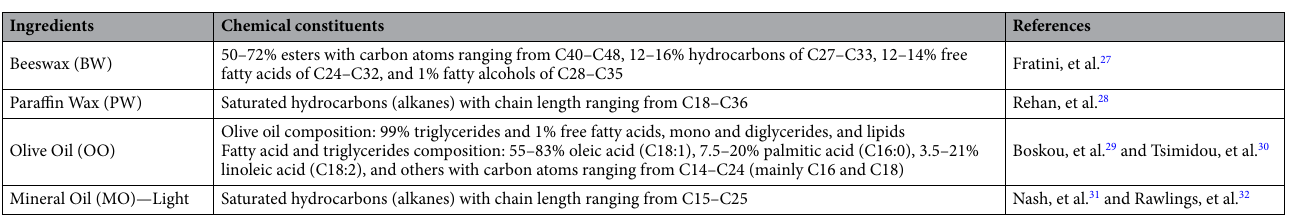
Table 1. General chemical constituents of ingredients used in wax-oil